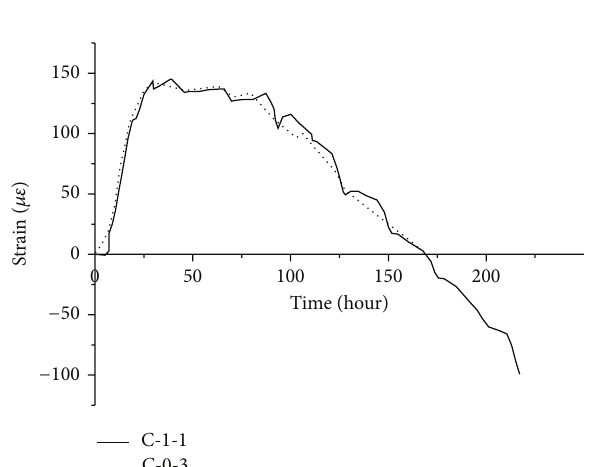
Figure 8: A typical evolution of (a) temperature and (b) strain.